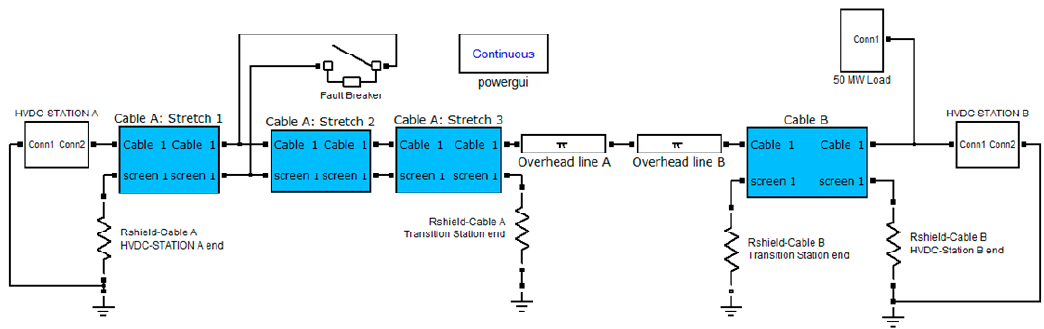
Table 4. Characteristics of 220 kV overhead line.